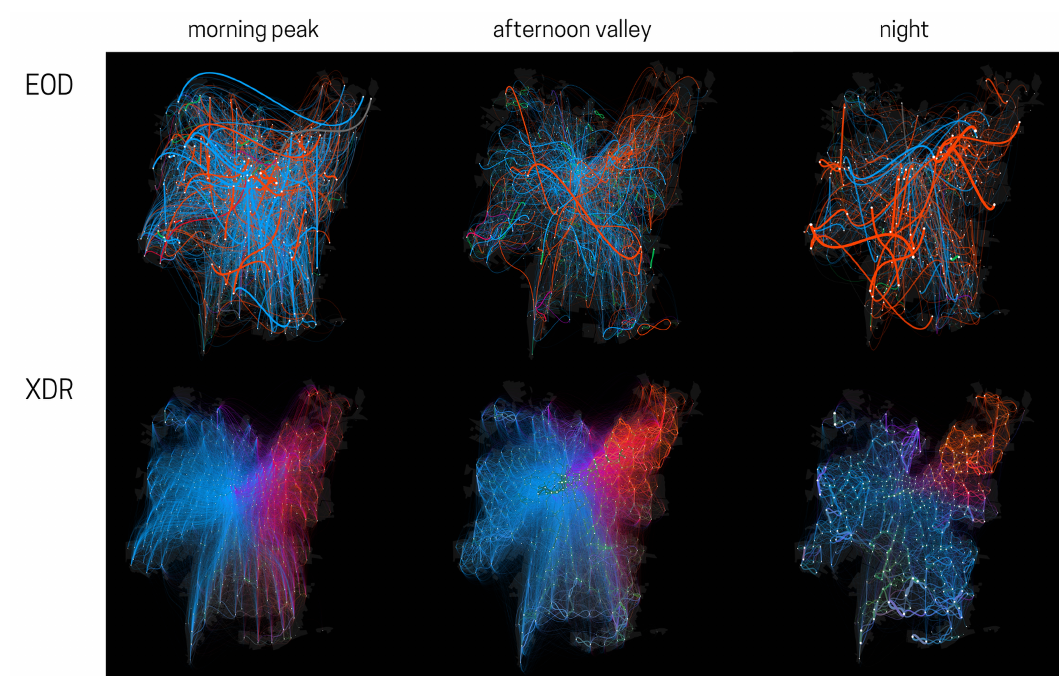
Figure 7. One day of mobility according to a travel survey (EOD) and a pervasive (XDR) dataset, visualized as flow maps on Modalflow.